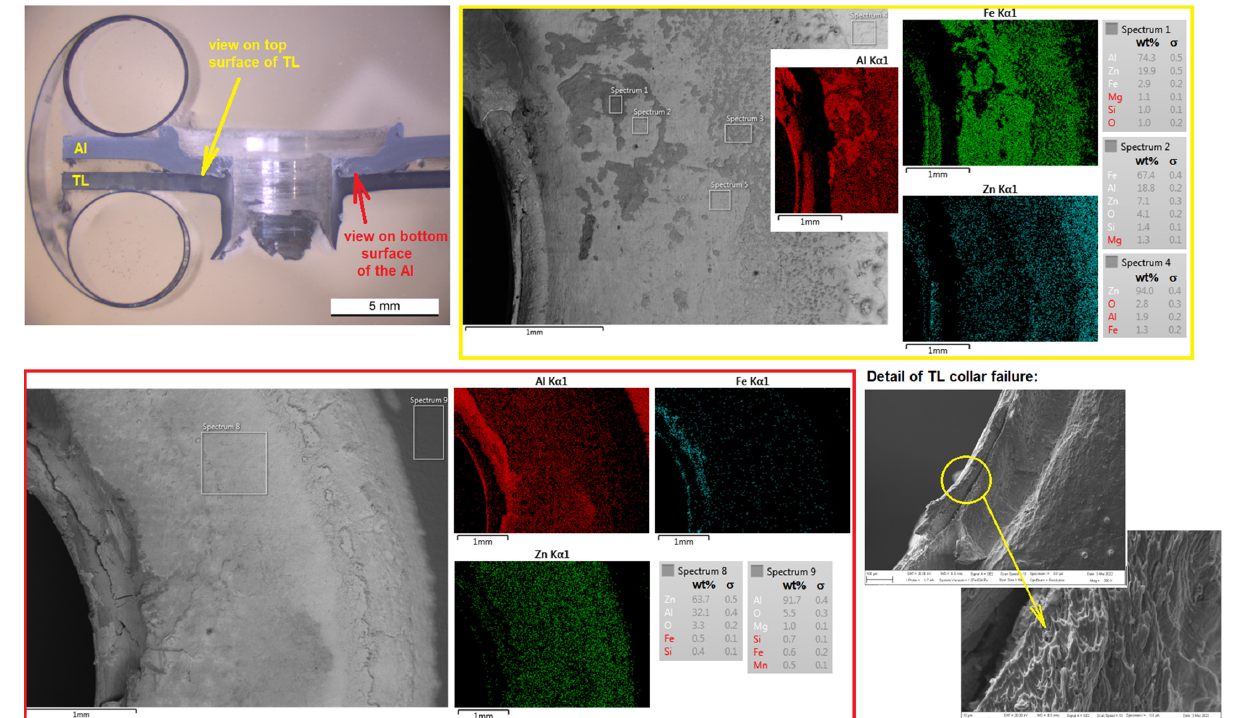
Figure 10. SEM analysis of Al-TL joint, element maps, EDS spectra, and fracture surfaces of bushing. The yellow border contains a detailed view on the top surface of the lower material. The red border contains a detailed view on the bottom surface of the upper material.